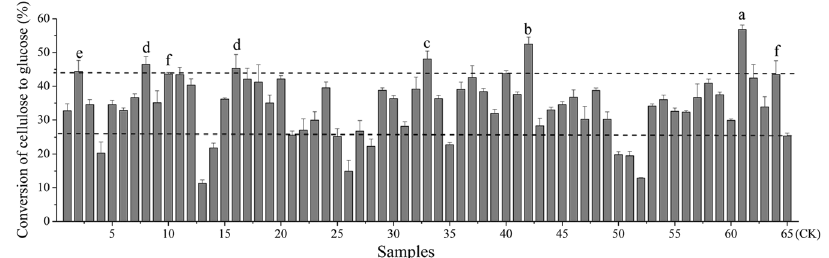
Figure 2. Conversion of cellulose to glucose after the enzymatic hydrolysis of bio-pretreated corn stover by 64 fungi. The data presented is average ± standard deviation for triplicate experiments for each fungal strain.